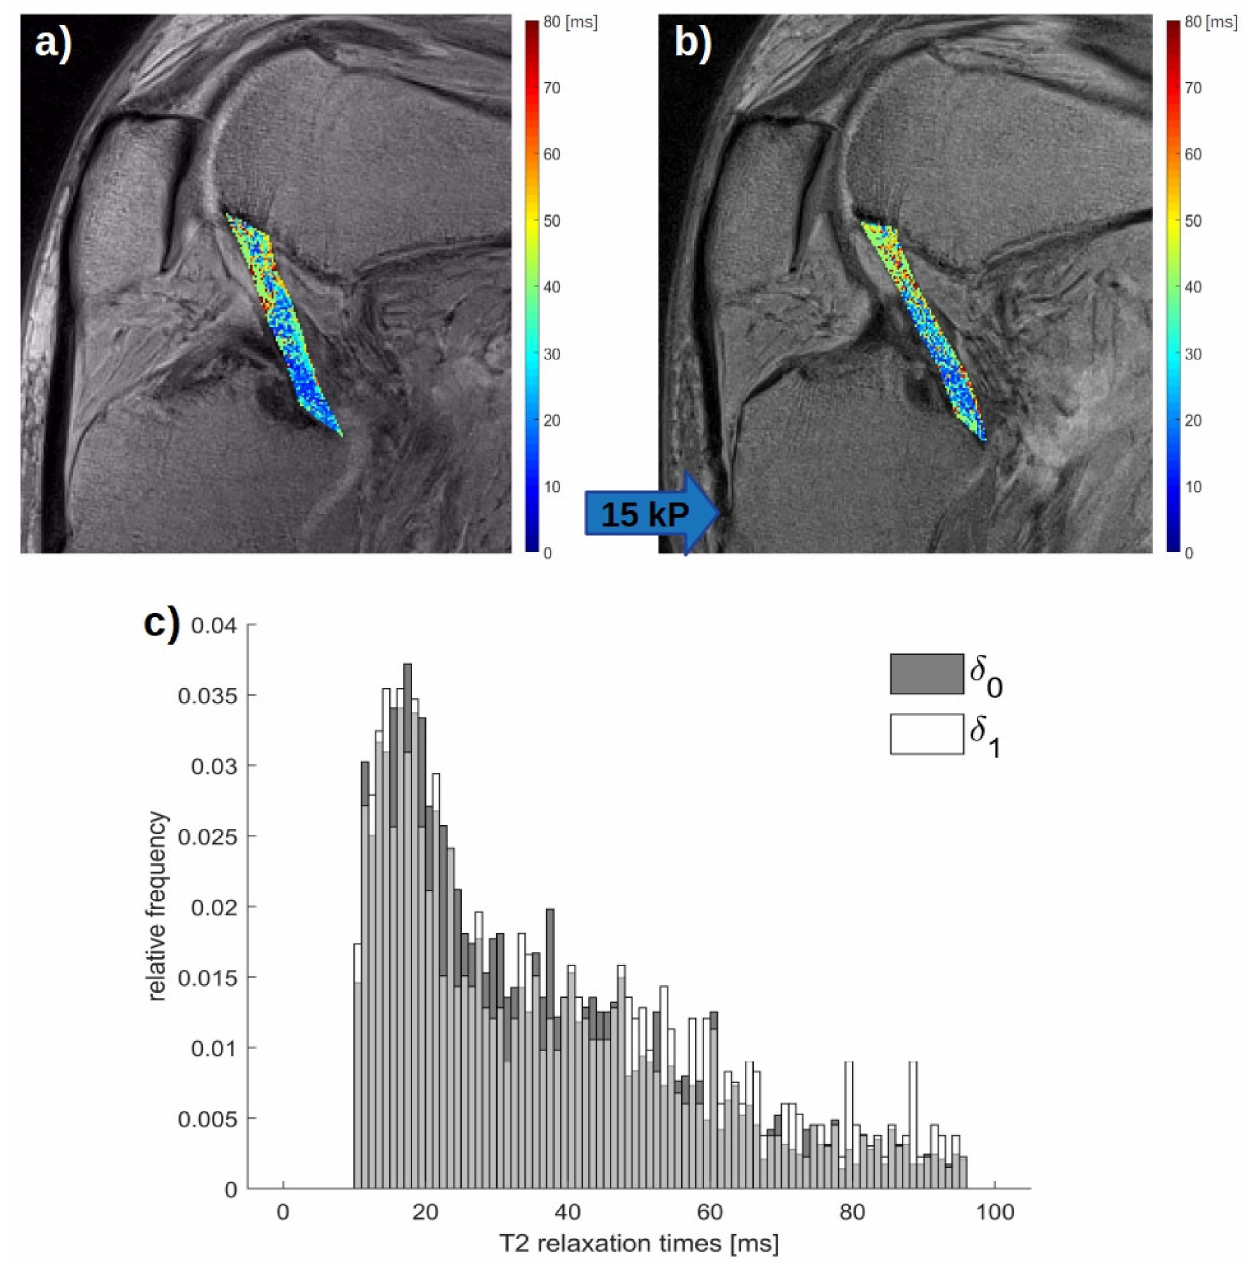
Figure 4. Quantitative T2 maps in the unloaded and loaded configurations and associated histogram of the posterior cruciate ligament (PCL). In this representative knee joint, spatially resolved T2 maps are displayed in the unloaded ( a ), ( δ 0 ) and loaded configurations ( b ), ( δ 1 ). T2 maps of the segmented PCL outlines were overlaid onto the corresponding T2-weighted morphologic images (echo time = 41.4 ms). The blue block arrow indicates the direction and magnitude of loading. T2 relaxation times are color-coded and range from 0 to 80 ms (right). ( c ) The associated histogram of pixel-wise T2 relaxation times of the PCL in this specimen indicates relative increases of high-T2 pixels in the δ 1 -configuration (white) as compared with more prevalent low-T2 pixels in the δ 0 -configuration (dark grey). The light grey bars indicate the overlaying T2 pixels of the δ 0 -configuration and δ 1 -configuration. Same right knee joint specimen as in Figures 1 and